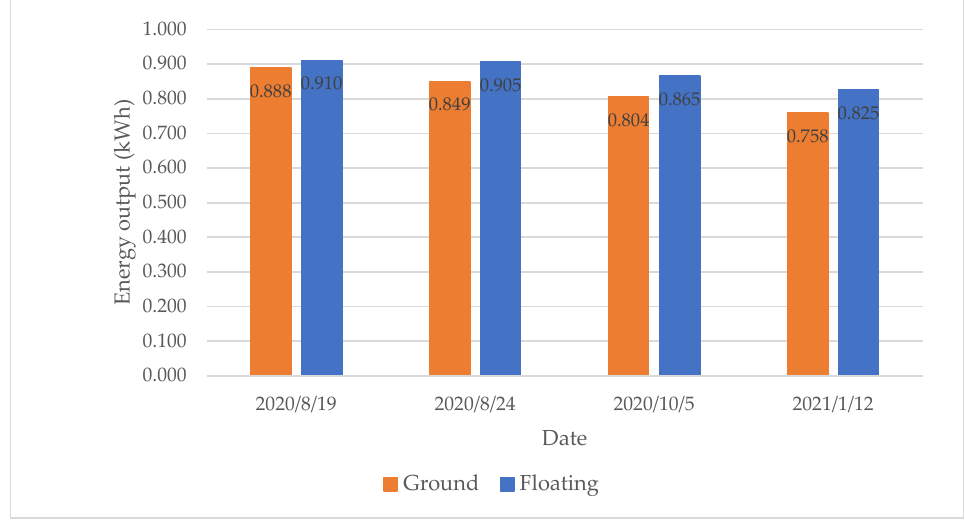
Figure 5. Energy output of different testing days for the period between 10 a.m. and 2 p.m. Table 2. Percentage increment for floating PV of different parameters with respect to ground- mounted PV.